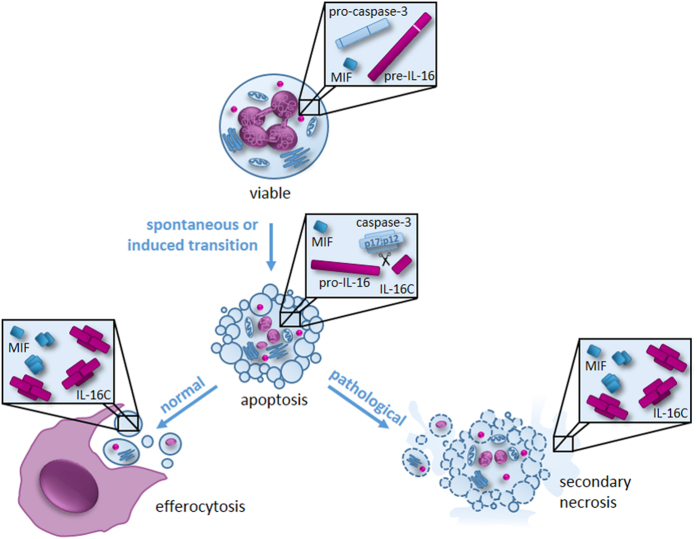
Schematic representation of the storage, processing and release of IL-16 and MIF in human neutrophils. MIF and IL-16 are preformed cytokines stored in the cytosol of human neutrophils. During apoptosis, the precursor of IL-16 (pre-IL-16) is processed into the biologically active IL-16C in a caspase-3-dependent manner. While under normal conditions, apoptotic cells are cleared by phagocytes, this process is impaired in infections and autoimmunity, leading to the release of MIF and IL-16C by secondary necrotic neutrophils.